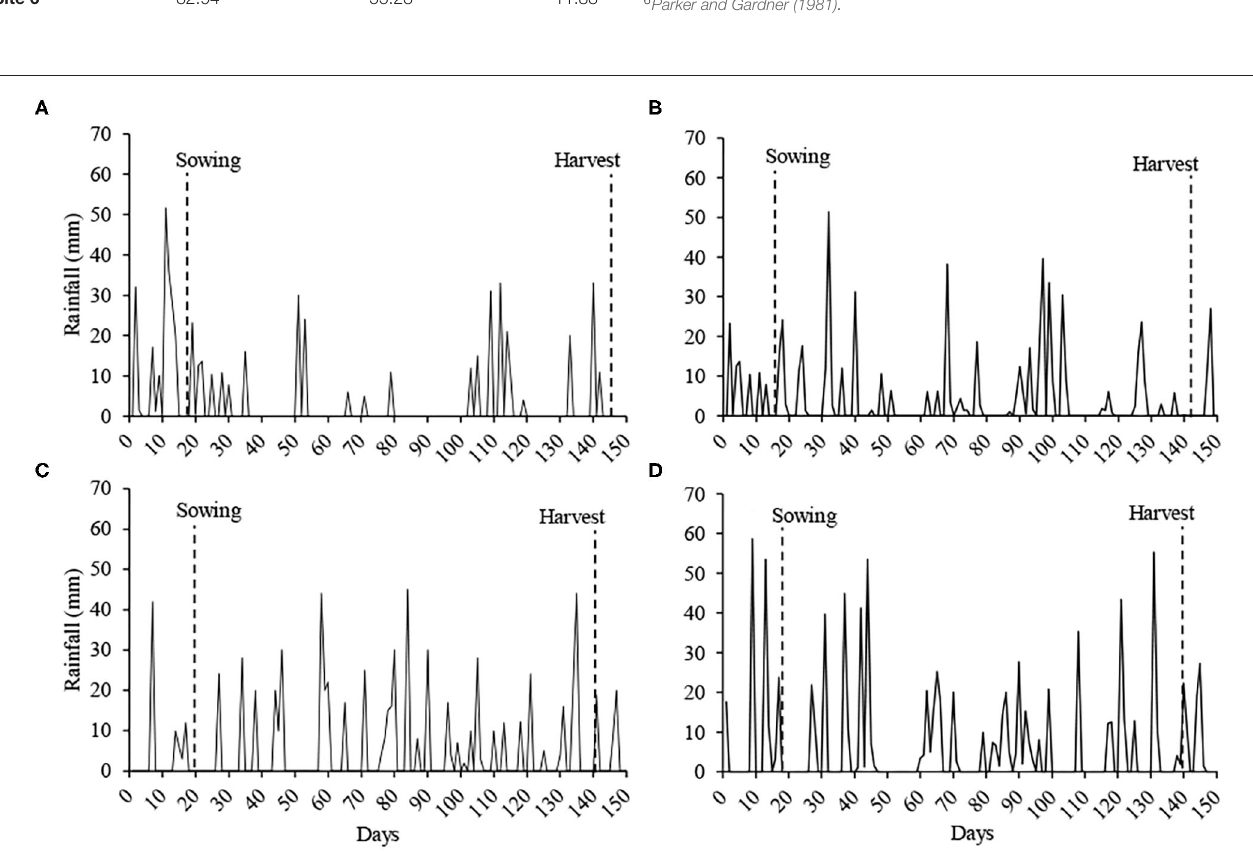
FIGURE 1 | Rainfall during the soybean cycle in the experiments. Sites 1 and 2 (A) , Site 3 (B) , Sites 4 and 5 (C) and Site 6 (D) . Source: Information collected on the property of the experiments of Sites 1 , 2 , 4 , and 5 , and Embrapa Wheat (2020) for Sites 3 and 6 .